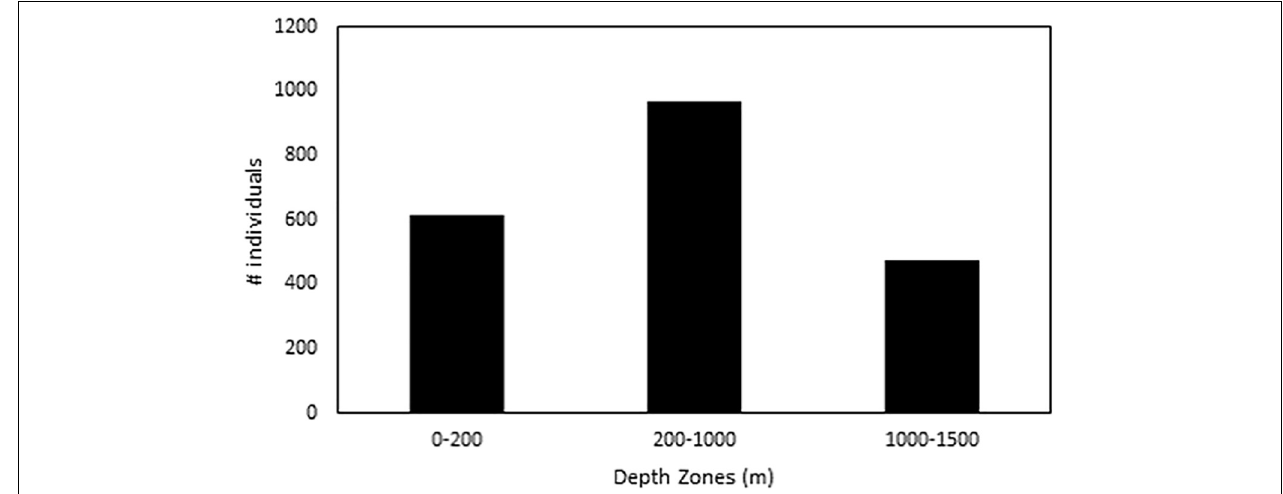
FIGURE 2 | Total cephalopod distribution divided into ocean zones from 0 to 1500 m